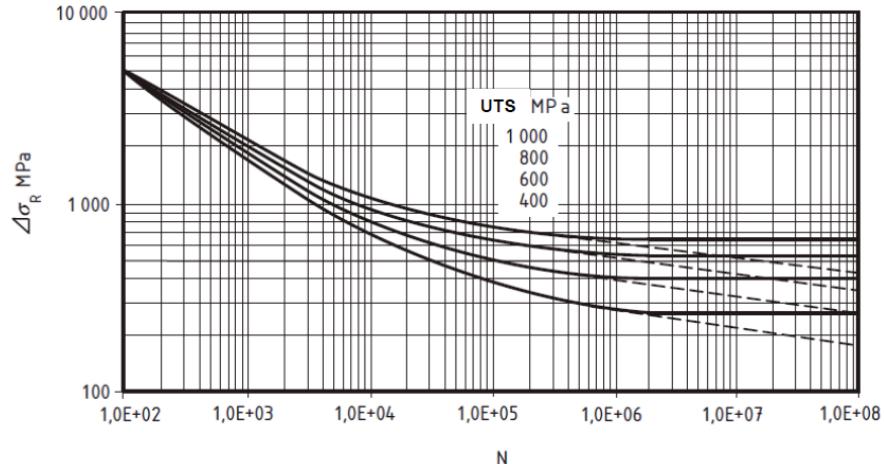
Figure 1. Fatigue curves for non-welded components in EN-13445 (reproduced from [19], European Committee for Standardization, 2014) . The different fatigue curves each correspond to a different ultimate tensile strength (UTS) level. The dashed lines correspond to fatigue endurance limits in the case of variable amplitude loads [19]. ∆ σ R represents the stress range.